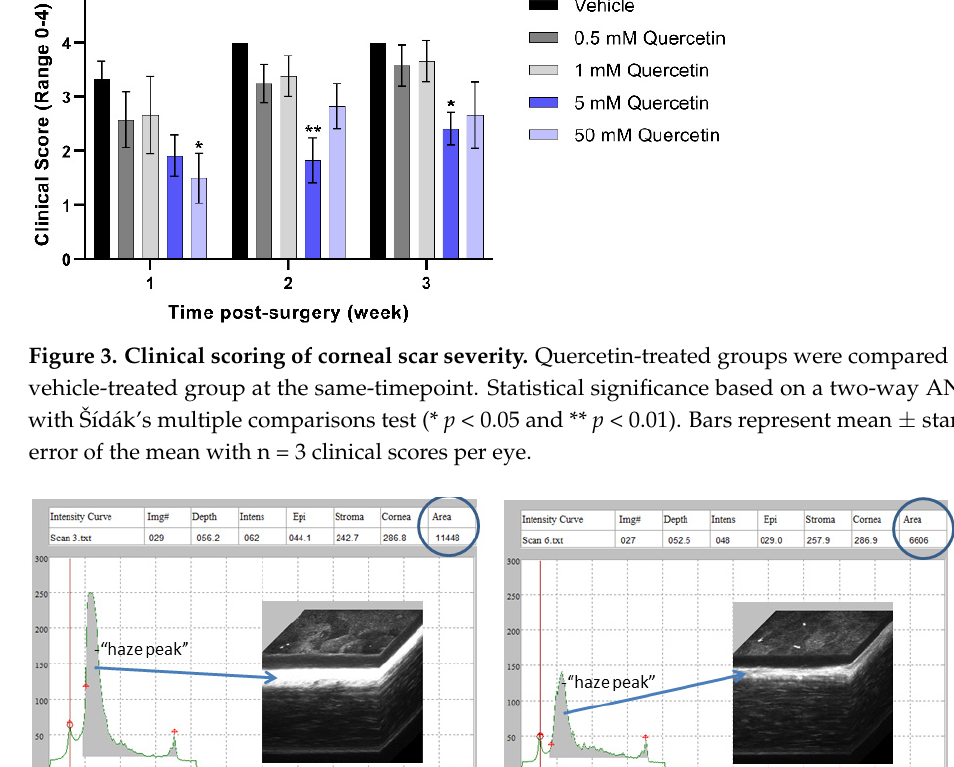
Figure 3. Clinical scoring of corneal scar severity. Quercetin-treated groups were compared to the vehicle-treated group at the same-timepoint. Statistical significance based on a two-way ANOVA with Šídák’s multiple comparisons test (* p < 0.05 and ** p < 0.01). Bars represent mean ± standard error of the mean with n = 3 clinical scores per eye.